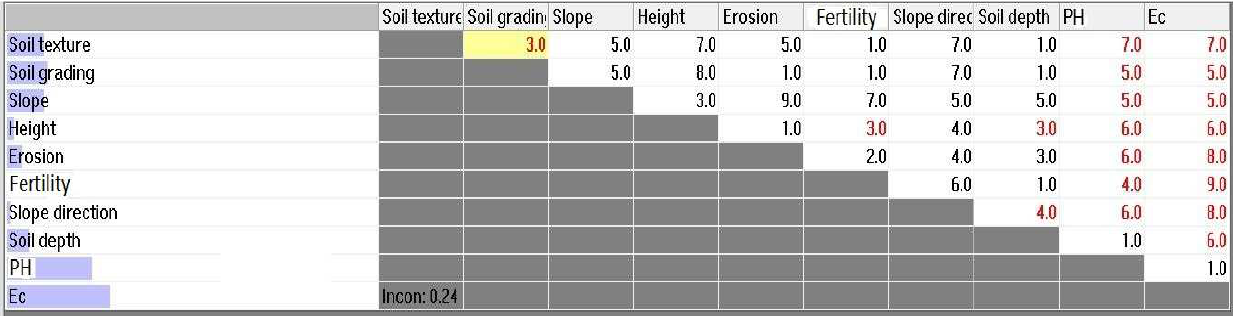
Figure 3. Pairwise comparisons between the 10